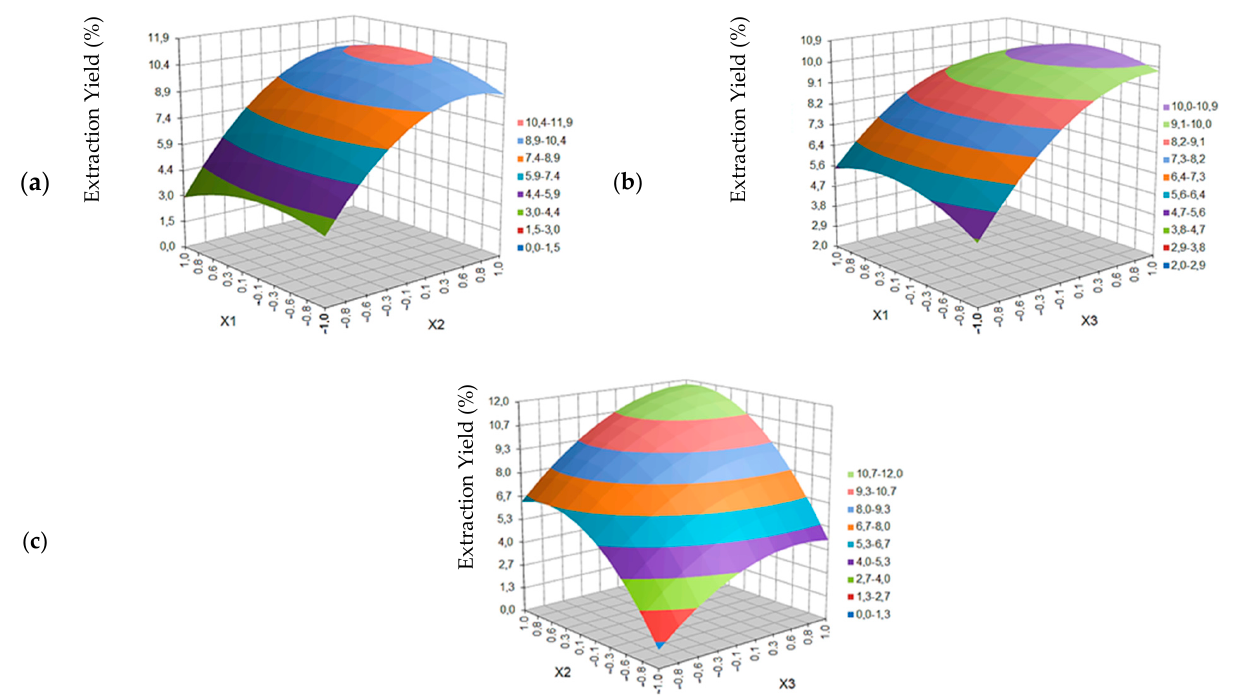
Figure 2. Response surface plot for blackcurrant seed extraction yield as a function of: ( a ) temperature ( X 1 ) and extraction pressure ( X 2 ), ( b ) temperature ( X 1 ) and extraction time ( X 3 ), ( c ) pressure ( X 2 ) and extraction time ( X 3 ).